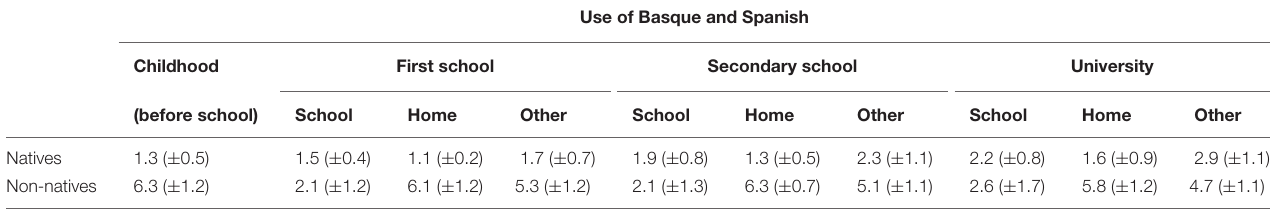
TABLE 2 | Language usage of participants at different periods of their life.